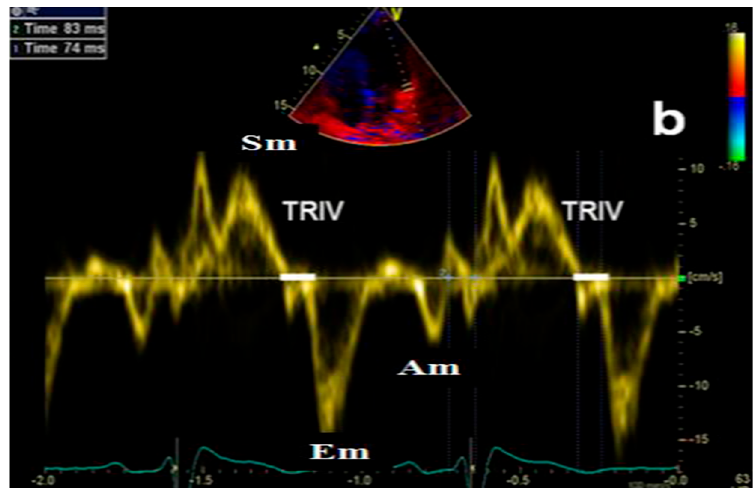
Figure 4. Echocardiographic assessment of isovolumetric relaxation time (IVRT) by Tissue Doppler Imaging (TDI). Am (or A’): late diastolic annular velocity (septal, lateral, and average) via tissue Doppler imaging; Em (or E’): early diastolic annular velocity (septal, lateral, and average) via tissue Doppler imaging; Sm: systolic annular velocity; TRIV: isovolumetric relaxation time.